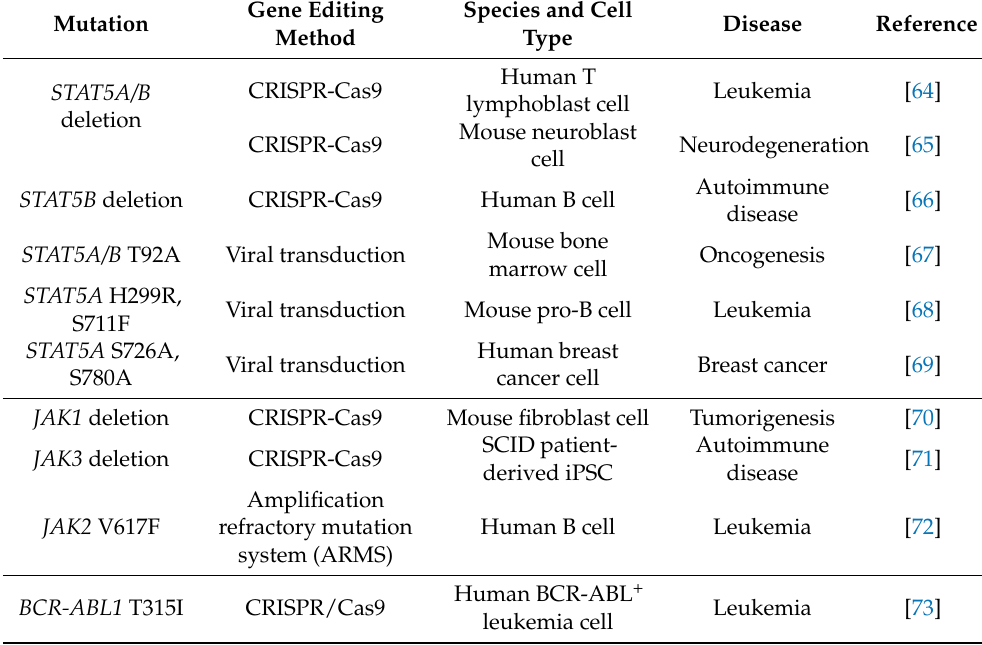
Table 3. Mutation models useful to study the role of STAT5 in